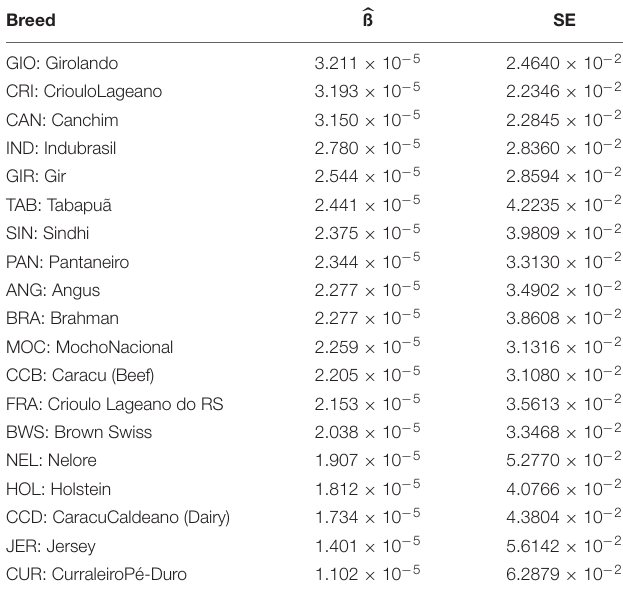
TABLE 2 | LD decay parameter estimates ( ˆ ß) and standard errors (SE) with p < 10 − 6 as the significance of β parameter of Sved model fitted to Brazilian cattle breeds.